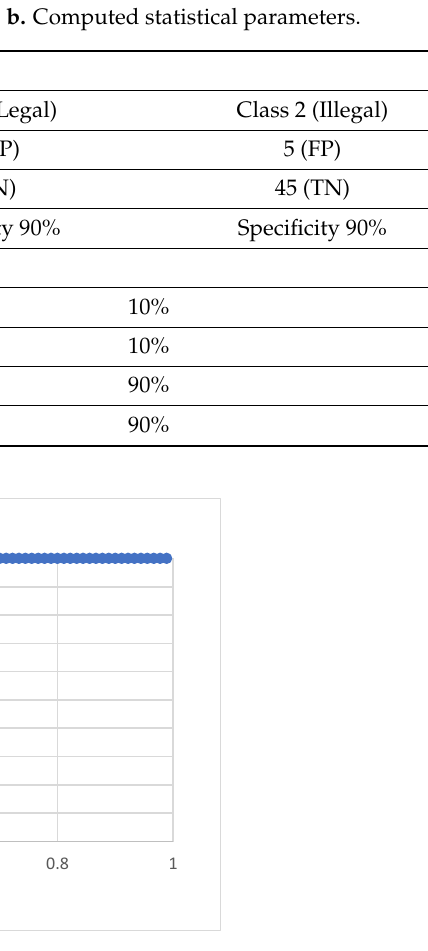
Figure 6. This figure shows the ROC curve for the